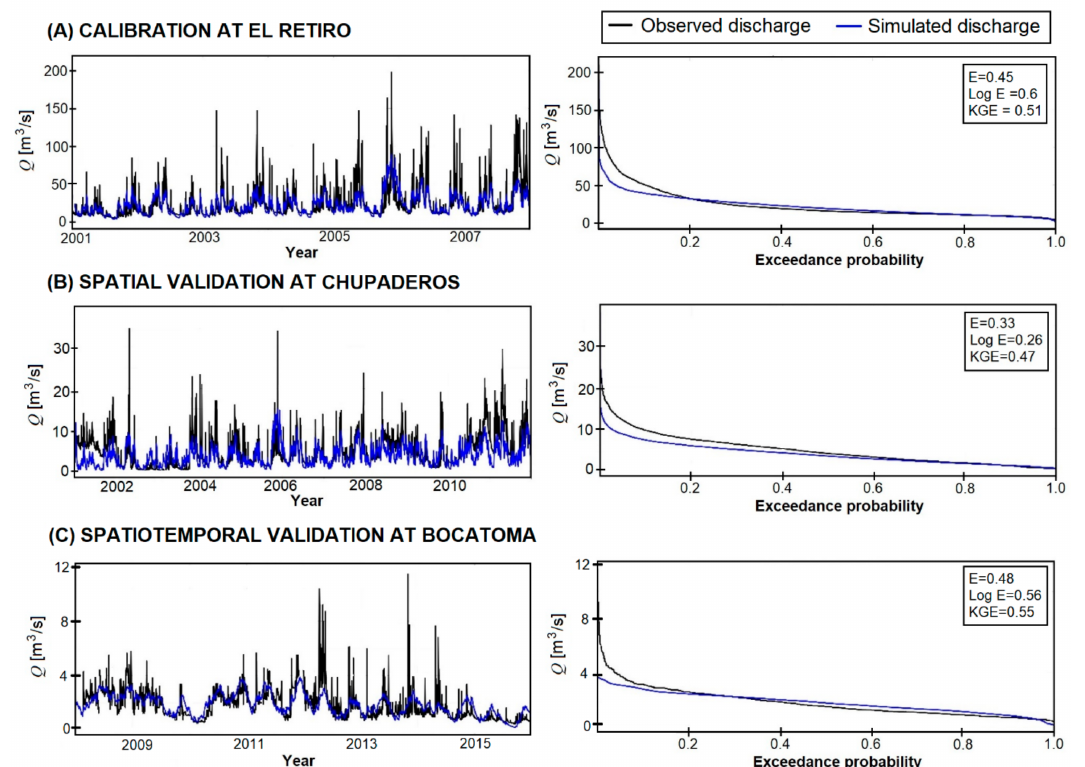
Figure 12. Calibration and validation results for the model implemented in WMF for the Chinchin á River basin. Row ( A ): simulated daily discharges and flow duration curve obtained in the calibration process at El Retiro station from 2001 to 2008. Row ( B ): simulated daily discharges and flow duration curve obtained in the spatial validation process at the Chupaderos station from 2001 to 2011. Row ( C ): simulated daily discharges and flow duration curve obtained in the spatial process at Bocatoma station from 2001 to